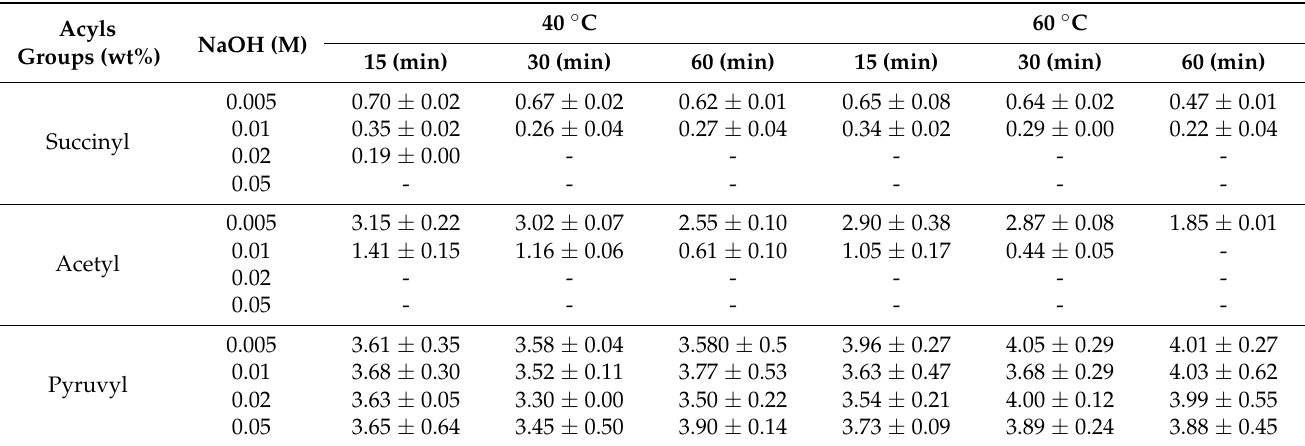
Table 1. Acyl groups (succinyl, acetyl, and pyruvyl) contents of FucoPol sample subjected to alkaline